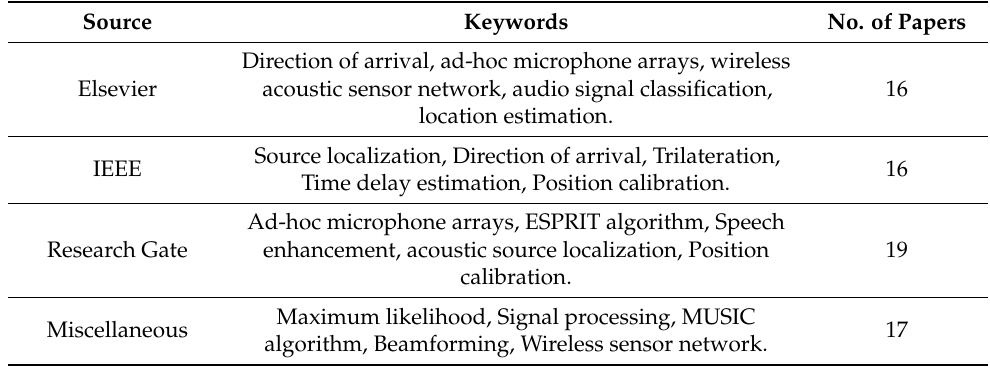
Table 1. A review of existing literature.